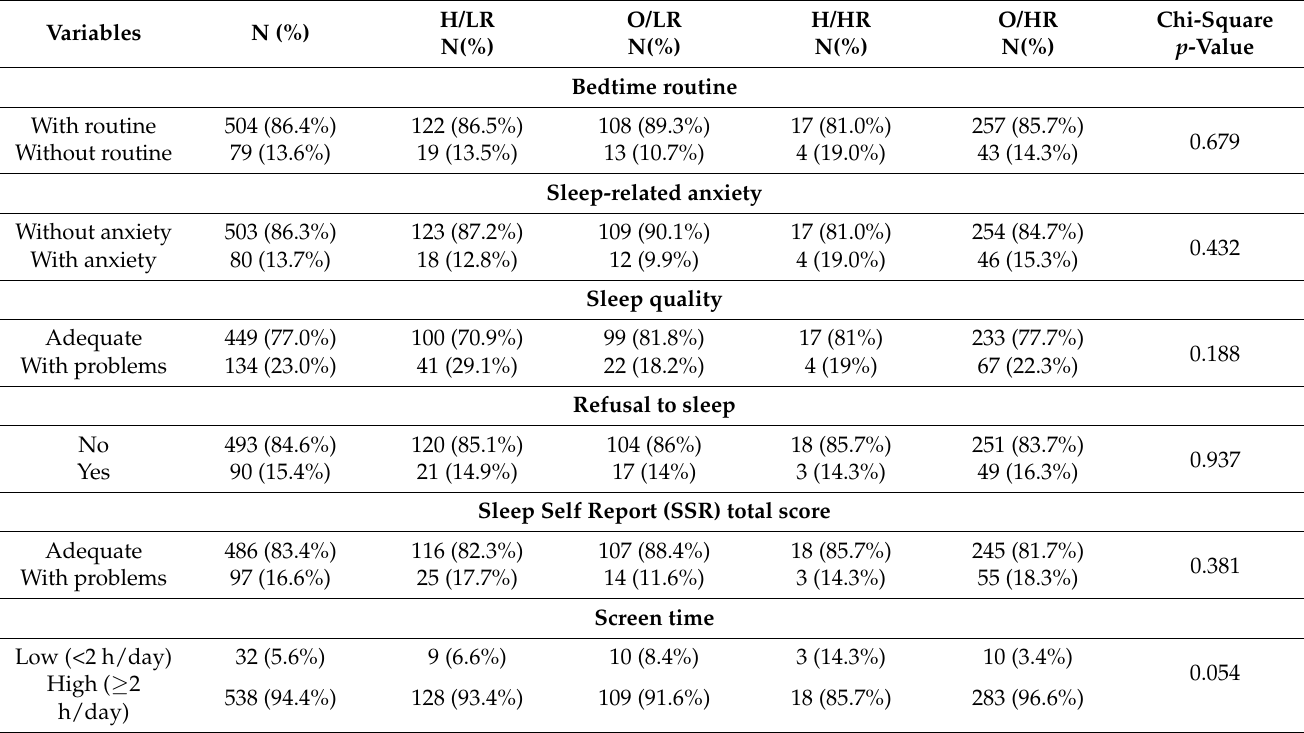
Table 3. Schoolchildren’s lifestyles according to sub-classification of obesity.